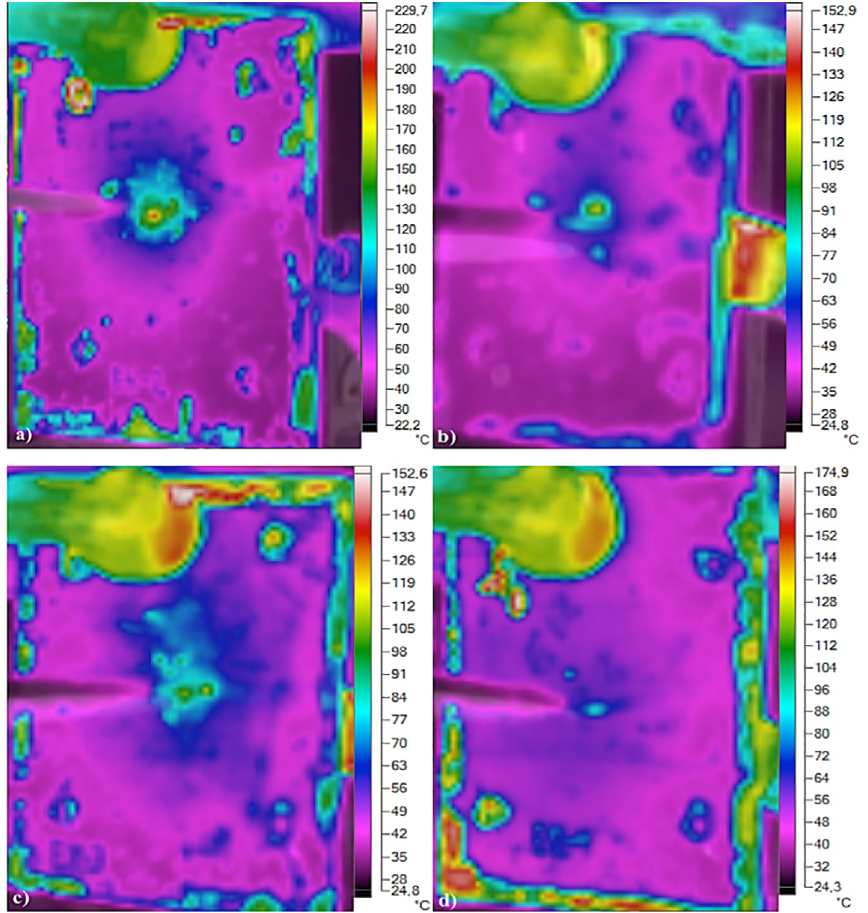
Figure 5. Temperature distribution for TAN10 sample after 30 min of blowtorch application: a) TAN10, b) TAN10-BM, c) TAN10-P and d)